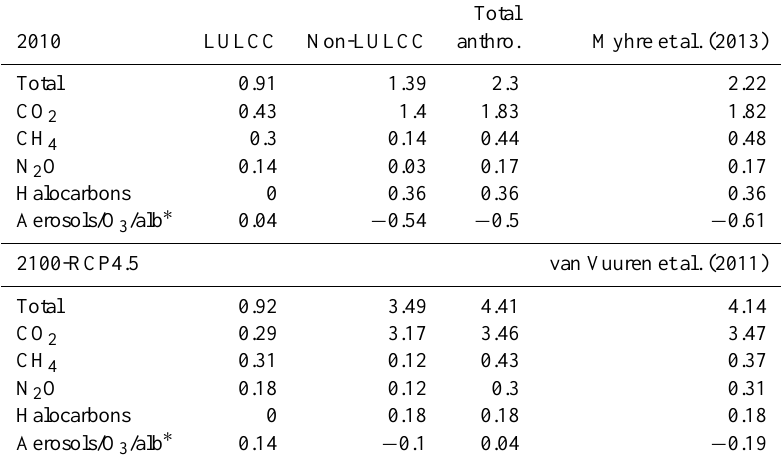
Table 3. Radiative forcings (Wm − 2 ) for the year 2010 and the year 2100 compared to Myrhe et al. (2013) and van Vuuren et al. (2011), respectively. For year 2100 we show the RF from RCP4.5 scenario emissions (referenced to year 1850) estimated from the modeling results in this study and from van Vuuren et al.